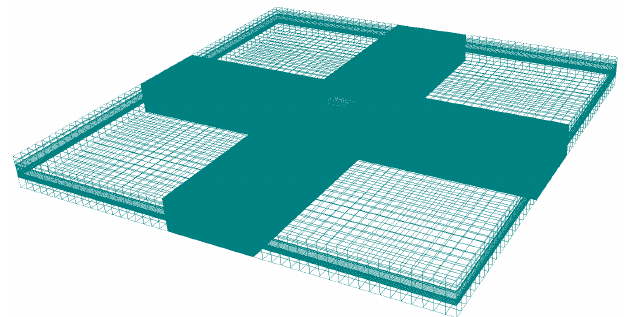
Figure 4. Numerical model of the MICP HSRB. Table 2. Hydraulic conductivity of the soil layers.